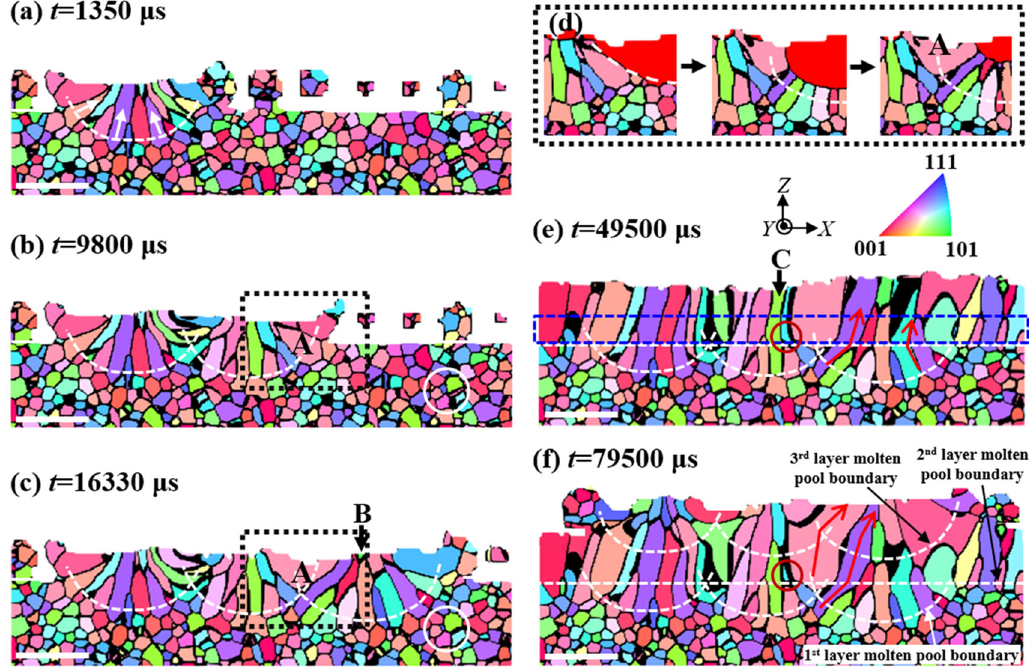
Fig. 4 Grain evolutions during SLM in the XZ cross section. a – c From the 1 st track to the 3 rd track in the 1 st layer; e after scanning the 2 nd layer; f after scanning the 3 rd layer. The scanning direction rotates 90 o between adjacent layers. d The grain evolution in the black dashed box during the 1 st layer 3 rd track in c . The white dashed curves represent the molten pool boundaries of the scanning tracks in the 1 st and 3 rd layers, and the white dashed straight line represents the molten pool boundary of the 1 st track in the 2 nd layer. The grain morphologies in the white circles in b and c illustrate the grain coarsening in the substrate, and the grain morphologies in the red circles in e and f illustrate the grain evolution in the un-remelted region of the 2 nd layer during the 3 rd layer scanning. The red arrows in e and f indicate the grain growth directions. Scale bar, 50 µm in a , b , c , e , f